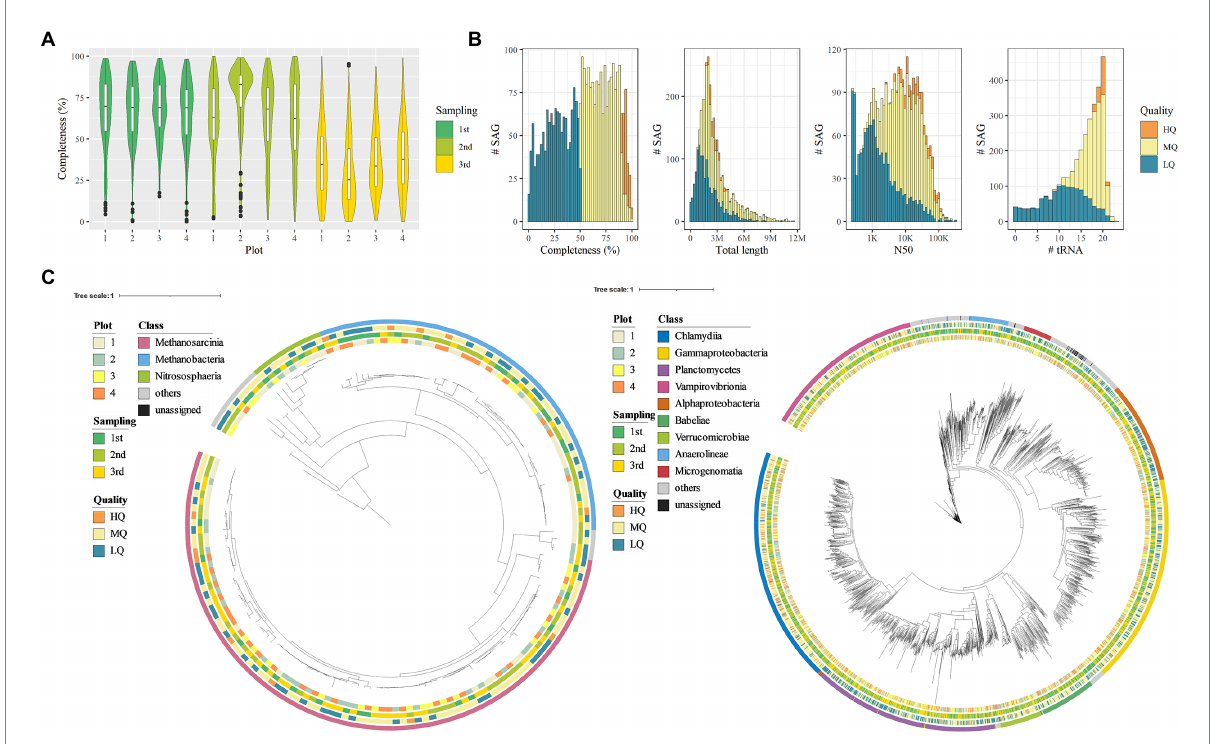
FIGURE 3 Quality and taxonomy classification of bacterial and archaeal single-amplified genomes (SAGs). (A) SAG completeness per sampling point. (B) Histogram of genome completeness, total length, N50, and the number of tRNAs corresponding to bacterial and archaeal SAGs. (C) Taxonomic tree based on archaeal/bacterial single-copy marker genes of SAGs (left, archaea; right, bacteria). The external color bars show the metadata and taxonomical annotation result (from inwards to outwards: plot, sampling time point, genome quality, and class-level